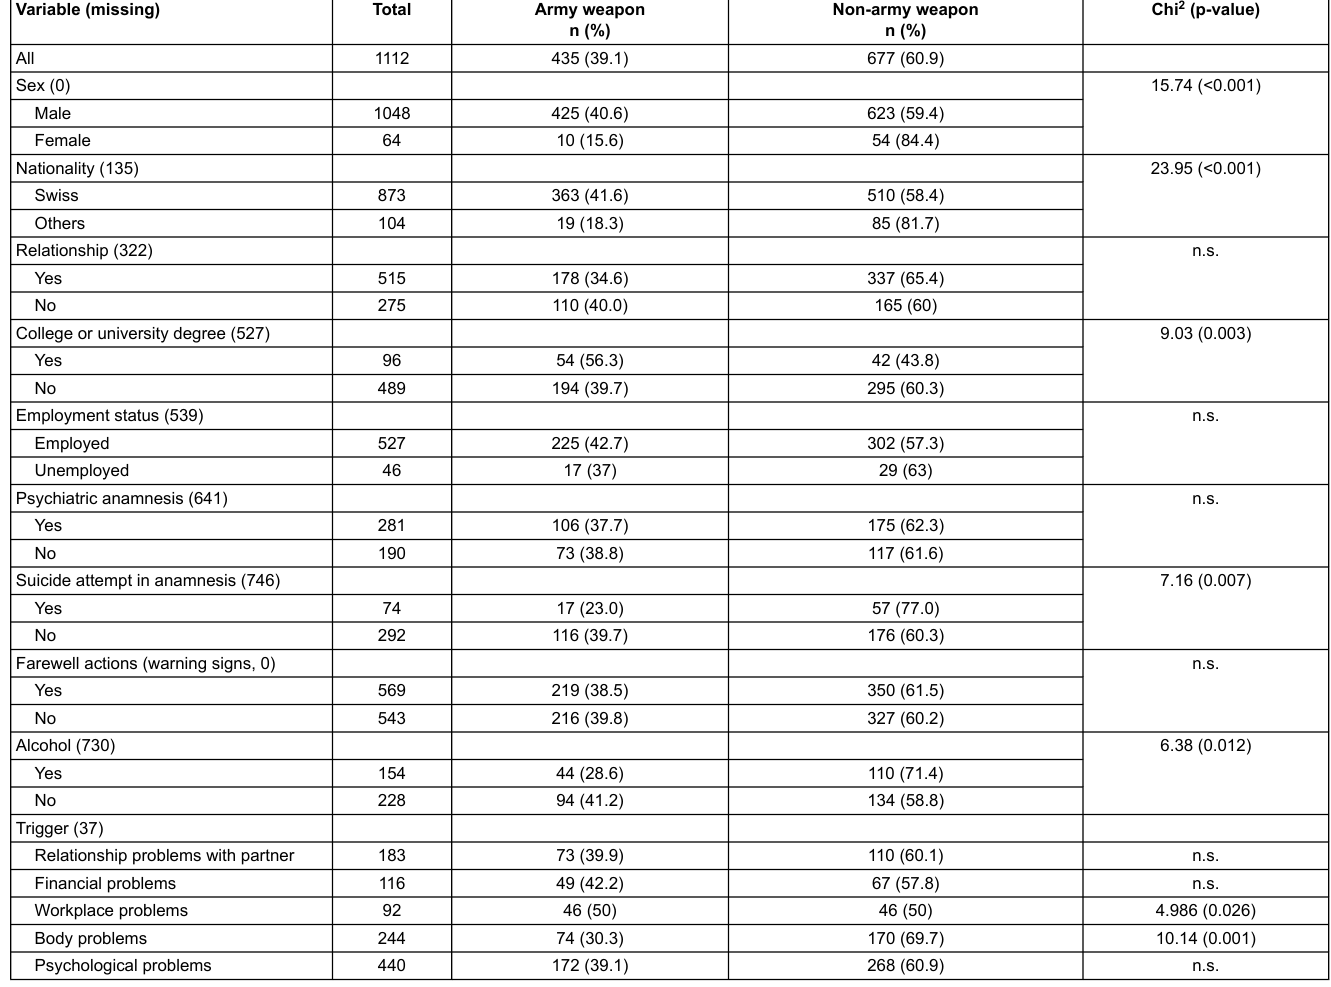
Table 2: Sociodemographic comparison of suicides using army weapons and non-army weapons . Variable